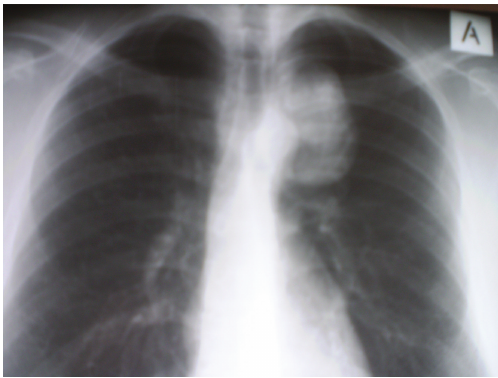
Figure 1: The posteroanterior chest radiograph shows a well- defined radiopaque lesion.